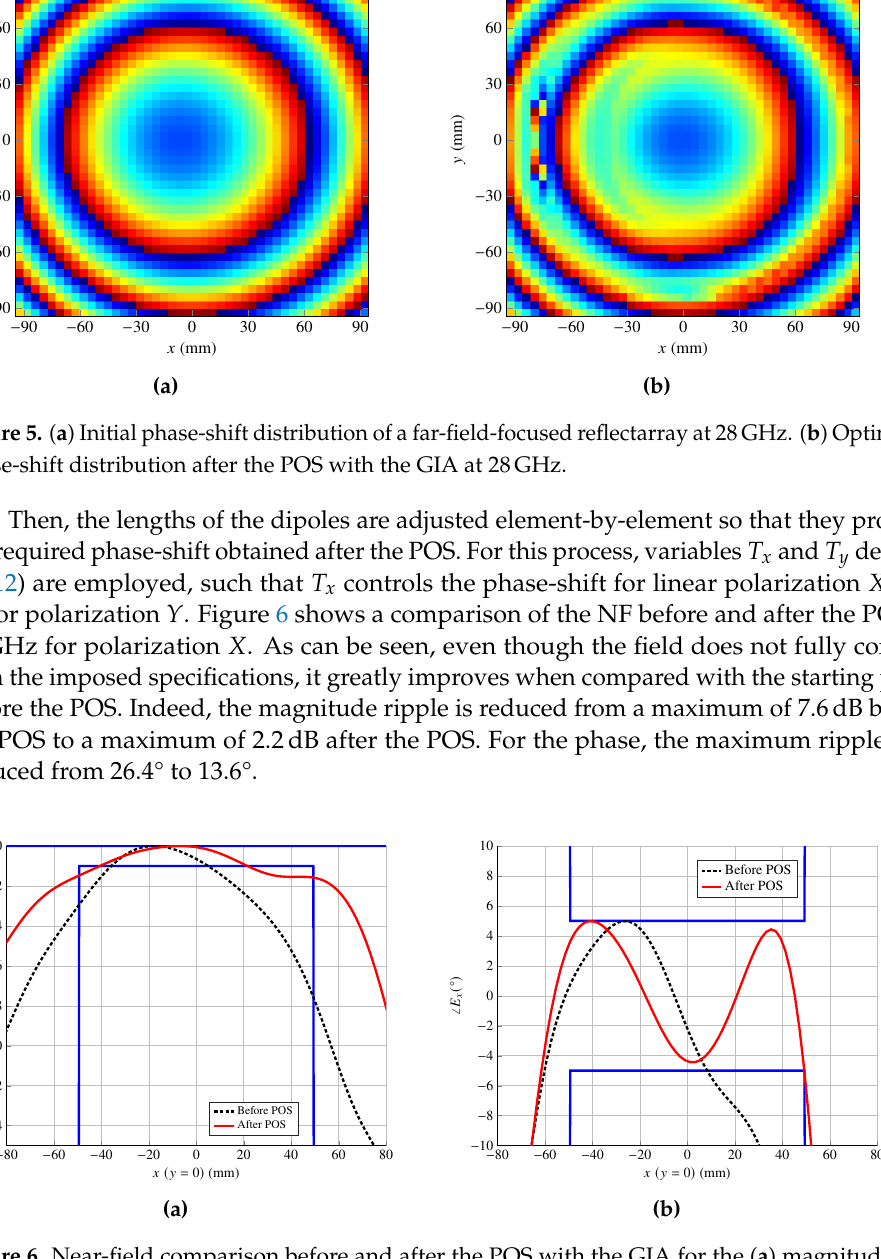
Figure 6. Near-field comparison before and after the POS with the GIA for the ( a ) magnitude and ( b ) phase for the cut y = 0mm at